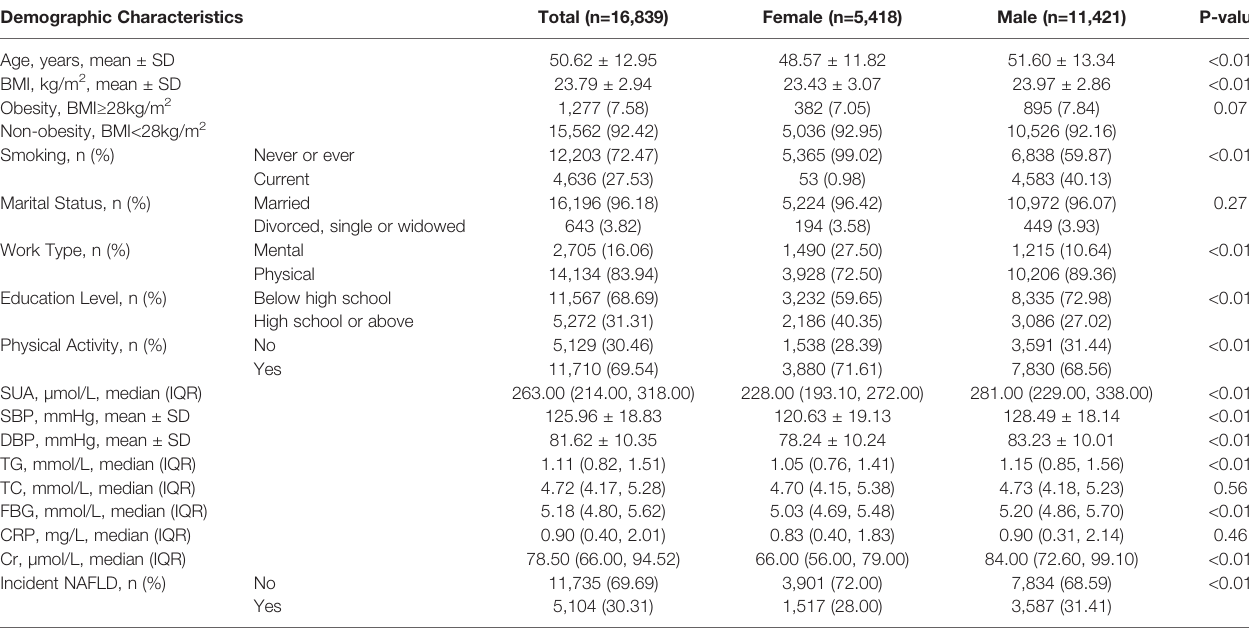
TABLE 1 | Demographic and serum biomarker information of the participants with no NAFLD in baseline in the Kailuan cohort study. Demographic Characteristics Total (n=16,839)